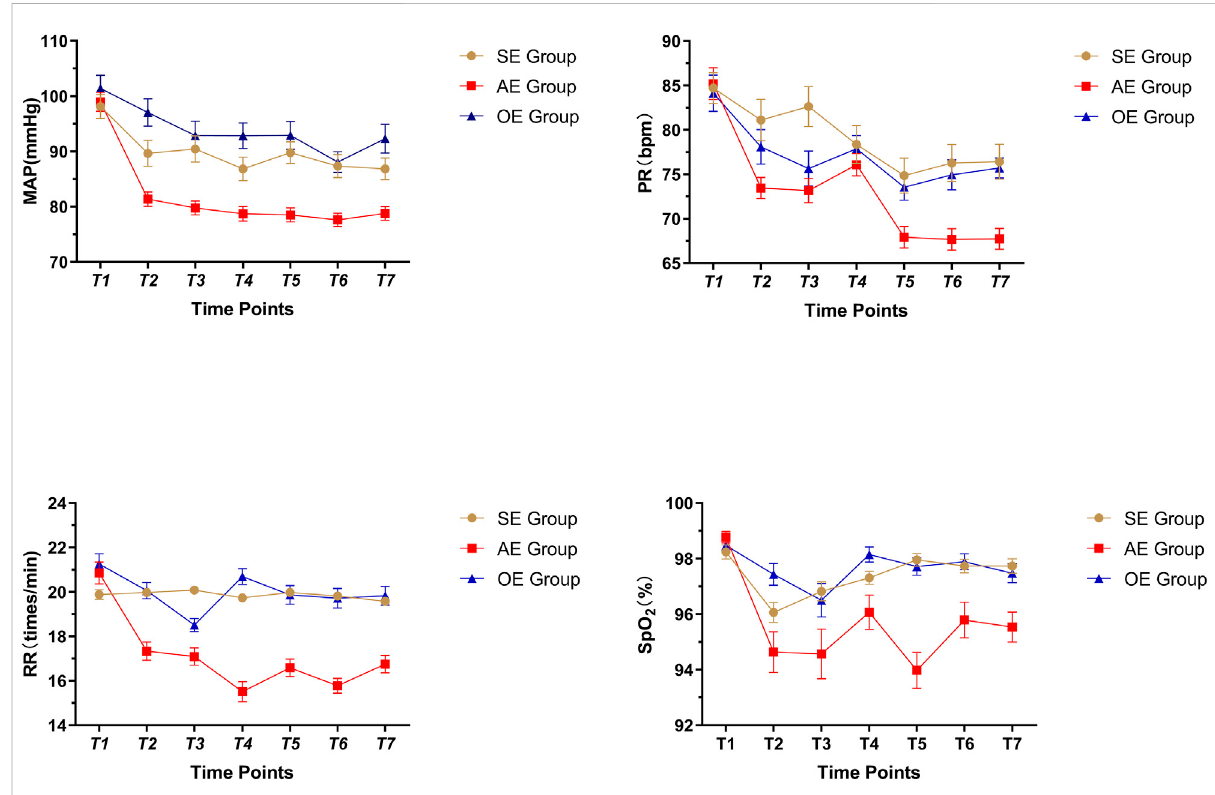
FIGURE 2 Comparison of vital signs in three groups, SE: sedation endoscopy, AE: anesthesia endocopy and OE: ordinary